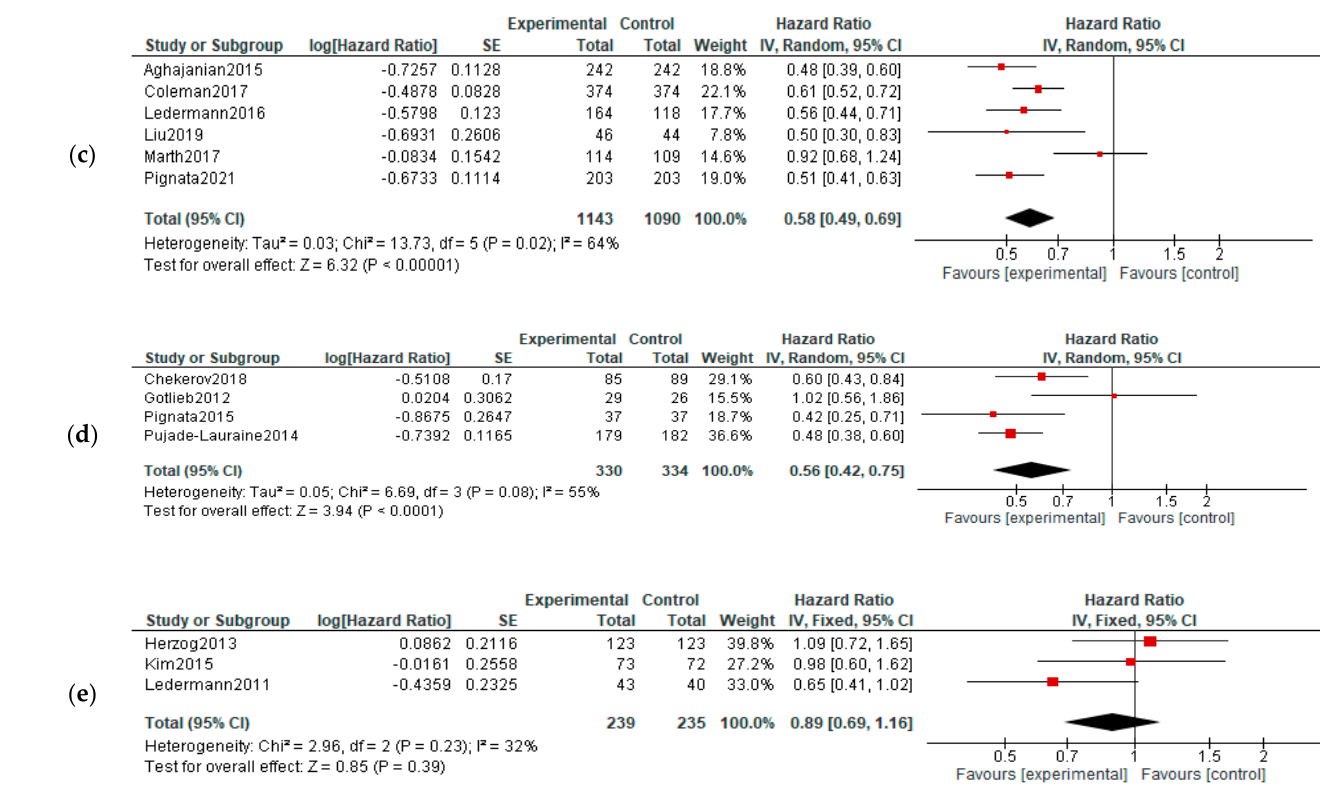
Figure 3. Settings subgroup analysis—time to progression: ( a ) first line, ( b ) recurrent, ( c ) P-S R, ( d ) P-R R and ( e ) maintenance. The black diamonds are visual representations of pooled effect and its confidence intervals and are non-significant if they overlap 1. Red squares represent each study effect size and study weight (size of square). The lines represent each study confidence interval.